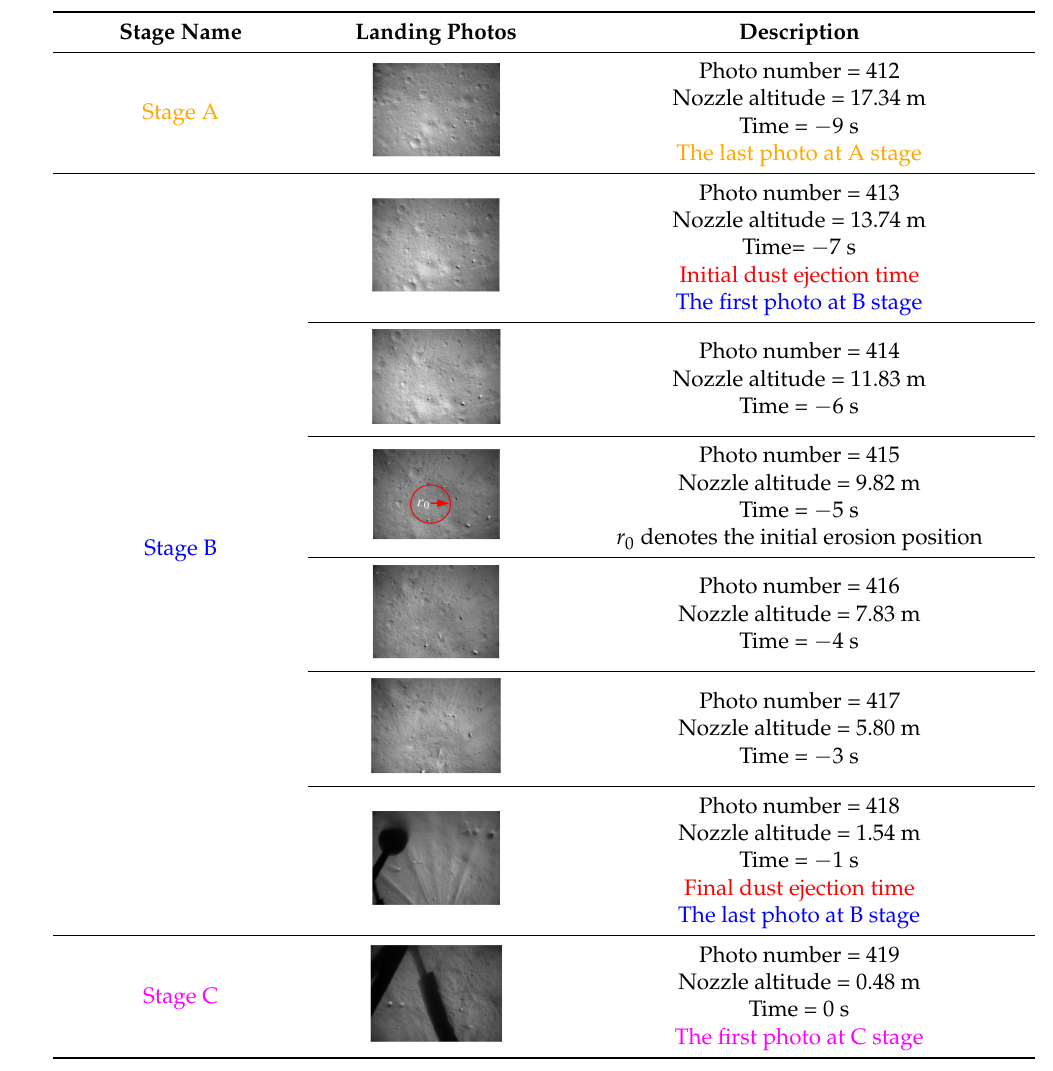
Table 2. Detailed landing photo description at the B